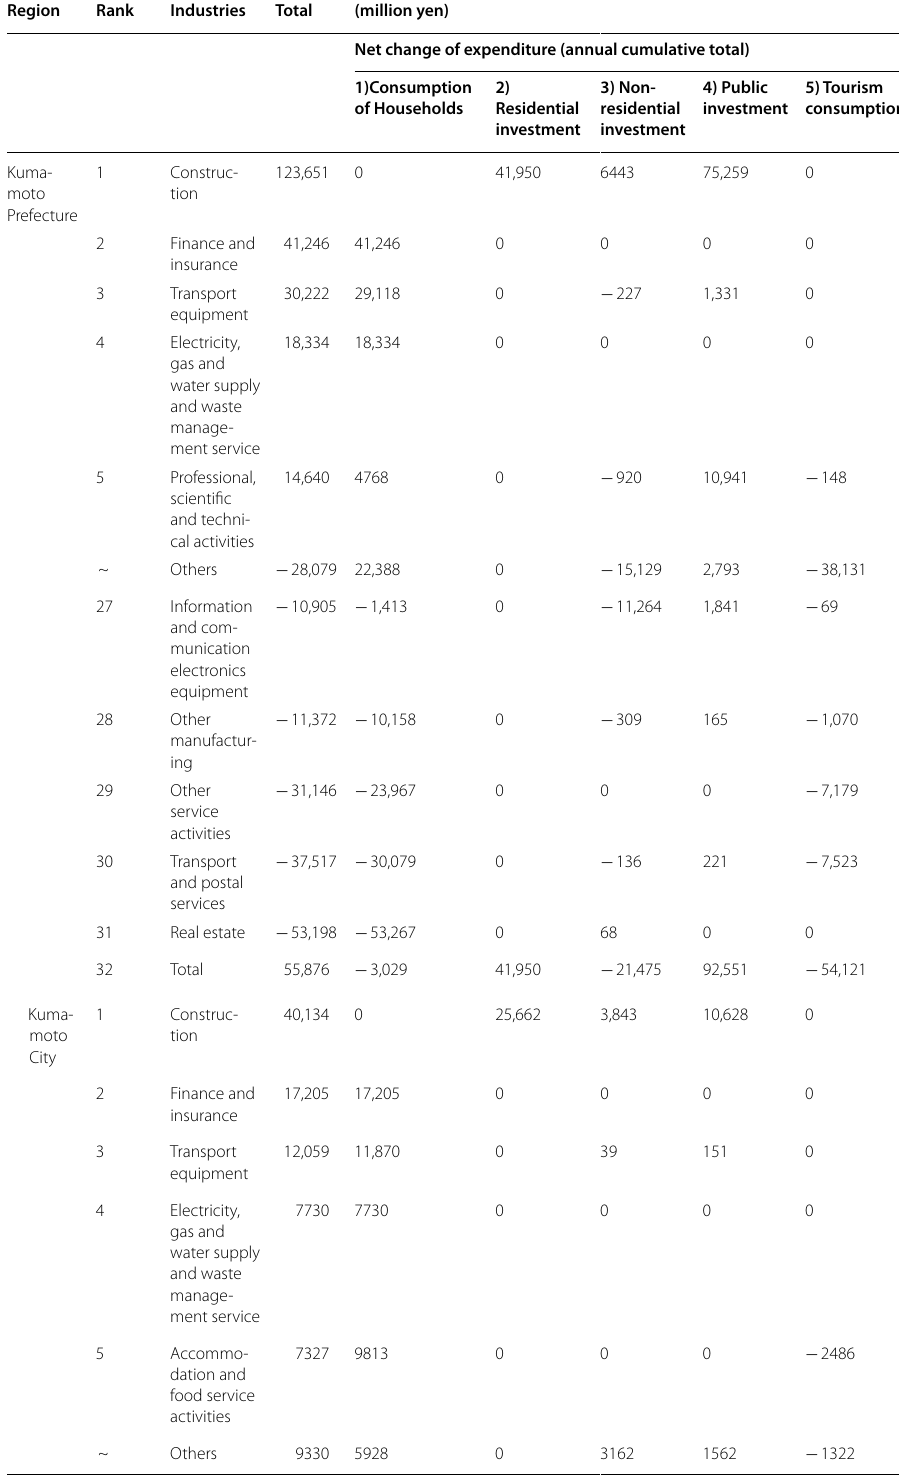
Table 5 Change of final demand (annual cumulative total, 31 sectors) Region Rank Industries Total (million